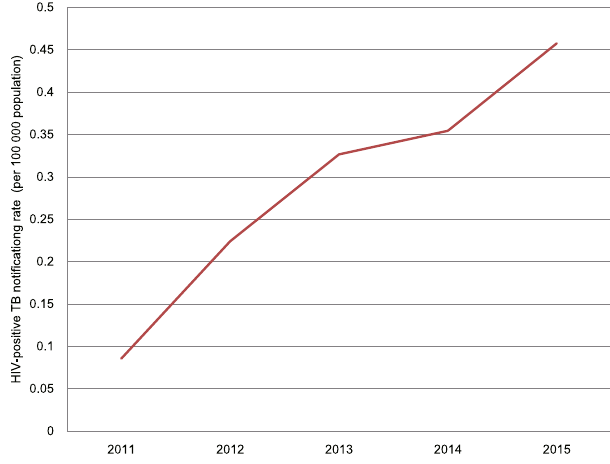
Figure 6. The notification rate of HIV-positive TB patients from 2011 to